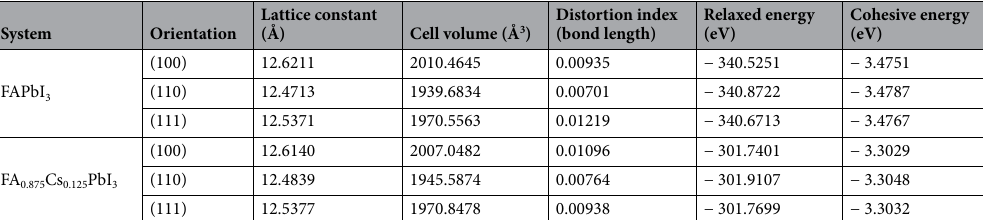
Table 1. Calculated lattice constant, cell volume, distortion index (bond length) and relaxed energy of FAPbI 3 and FA 0.875 Cs 0.125 PbI 3 .